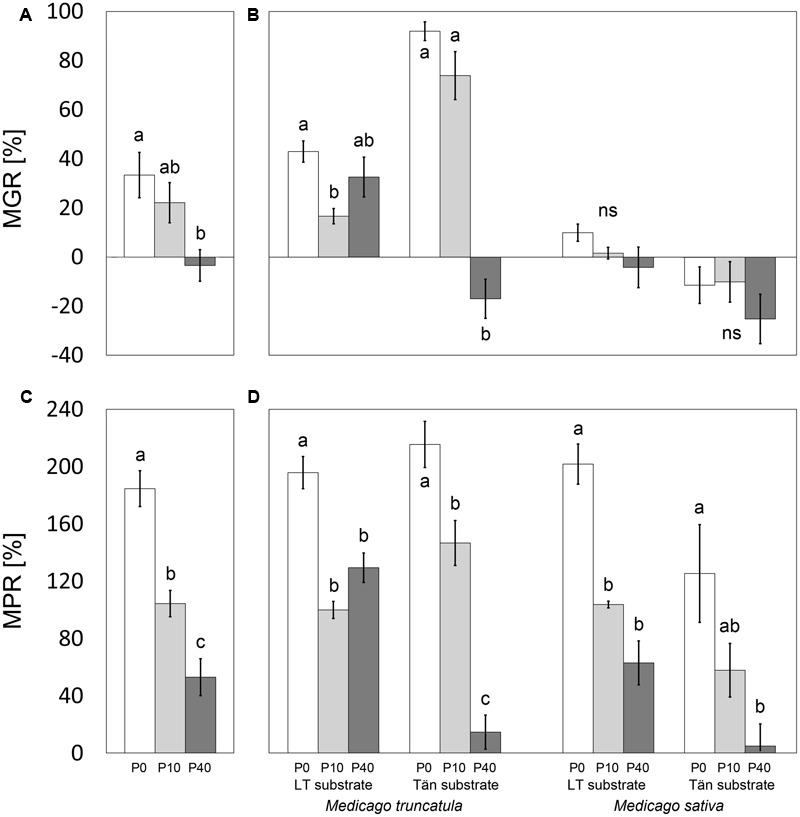
Mycorrhizal growth response (MGR) and mycorrhizal phosphorus-uptake response (MPR) of plants along a phosphorus fertilization gradient consisting of three input levels (0, 10, and 40 mg P added per pot; P0, P10, and P40, respectively). The results are shown either for the whole data set (A,C), or separately for M. truncatula or M. sativa plants grown in sand–zeolite substrate with 10% of either Litoměřice or Tänikon soil (LT or Tän substrate, respectively). Means ± standard errors are shown (n = 19 or 20 for A and C, n = 4 or 5 for B and D). Different letters indicate significant differences between different P levels within each plant–substrate combination according to Tukey’s HSD test (p < 0.05); ns, p ≥ 0.05.